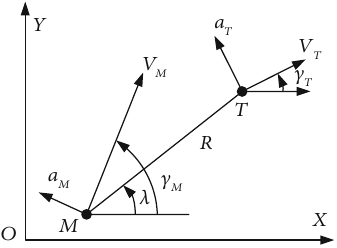
Figure 1: Planar homing engagement